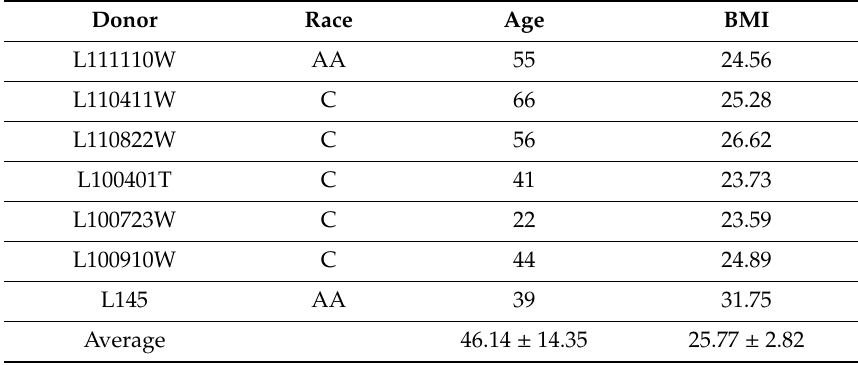
Table 1. Adipose derived stromal / stem cell donor demographic